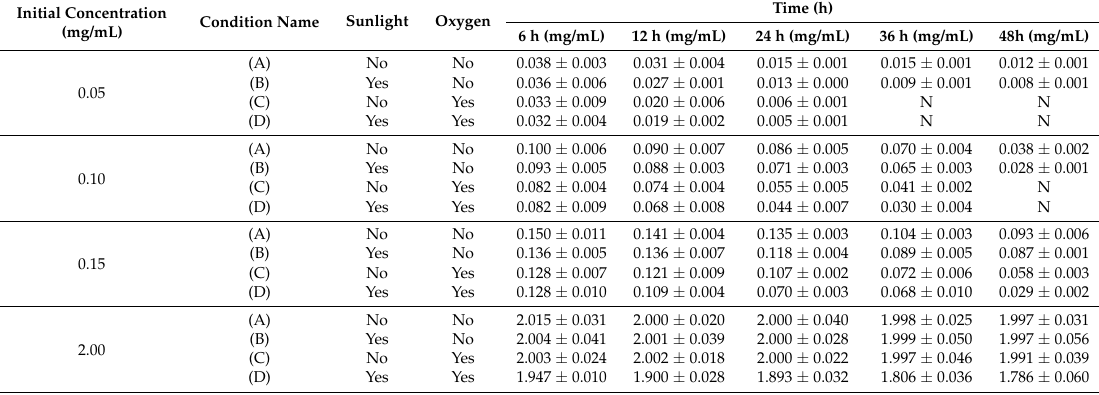
Table 3. The residual concentration of EGCG in the EGCG aqueous solution stored with or without sunlight and air for different time periods.